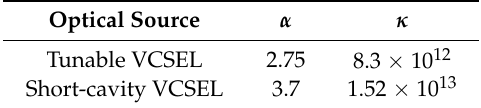
Figure 2. Channel transfer functions obtained after 10-km (blue), 24-km (red) and 34-km (yellow) SSMF propagation for: ( a ) 8-GHz tunable VCSEL and ( b ) 20-GHz short-cavity VCSEL. Table 1. Measured chirp parameters of the two VCSEL sources.